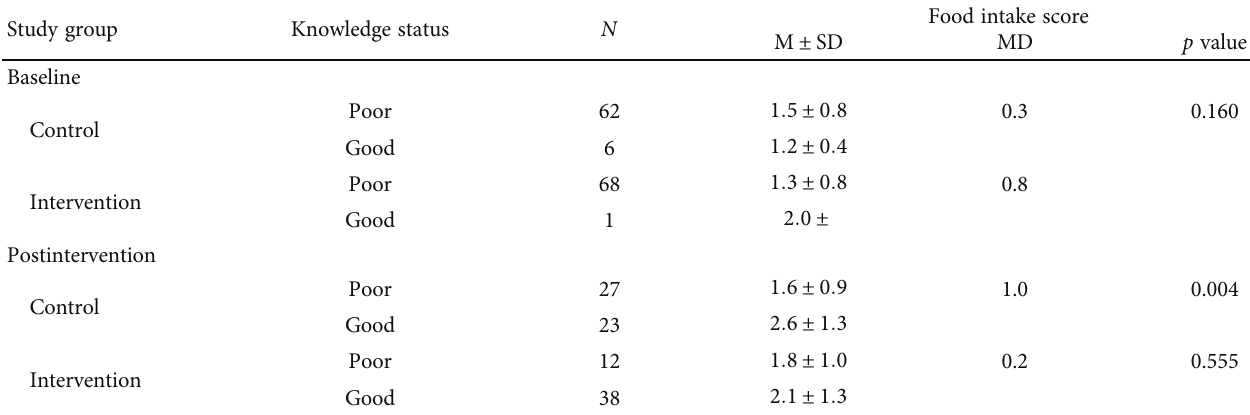
Table 6: Knowledge status and iron-rich food intake score within the study groups.